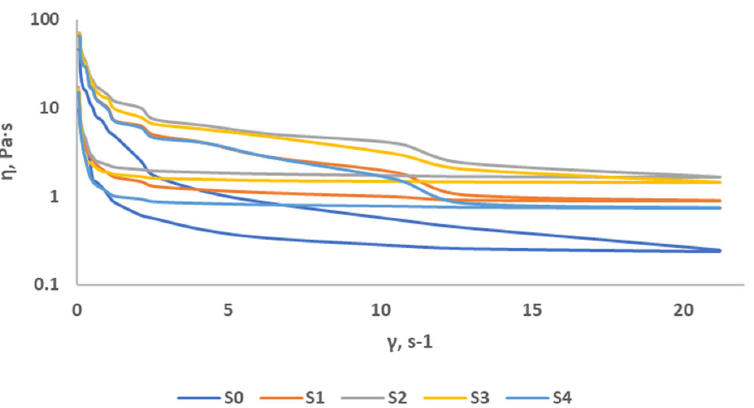
Figure 2. Hysteresis loop for the mayonnaise samples: S0—mayonnaise without BPP, control; S1—mayonnaise with 1.5% BPP; S2—mayonnaise with 3% BPP; S3—mayonnaise with 5% BPP; S4—mayonnaise with 7% BPP.